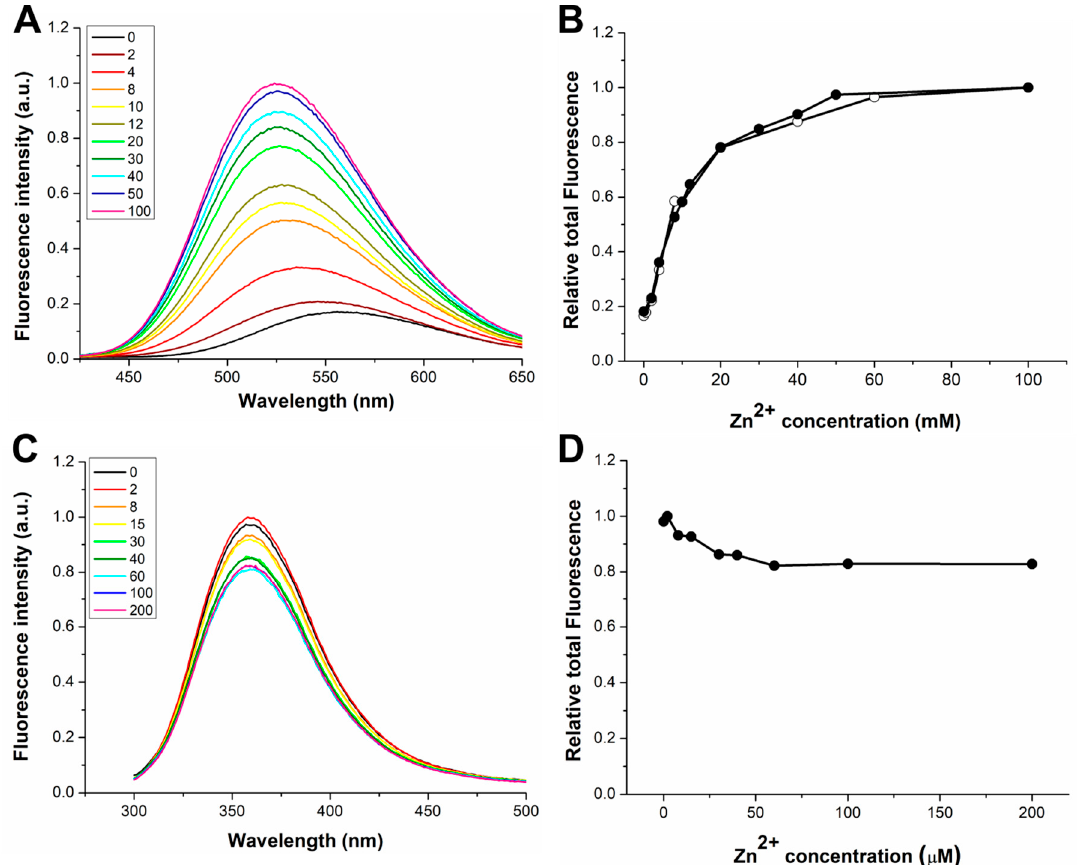
Figure 3. Fluorescence response of dH3w(W6A) and AcH3w as function of Zn(II) concentration. Emission spectra of ( A ) dH3w(W6A) and ( C ) AcH3w. The legends show the concentrations of Zn(II) in µ M units. Normalized area of the fluorescence emission as function of the Zn(II) concentration for ( B ) dH3w(W6A) and ( D ) AcH3w (filled circles). ( B ) The normalized area of the fluorescence emission of dH3w (void circles) is also shown for comparison. Spectra of dH3w(W6A) were registered after excitation at 340 nm (the absorption maximum of the dansyl group). Spectra of AcH3w were registered after excitation at 295 nm.